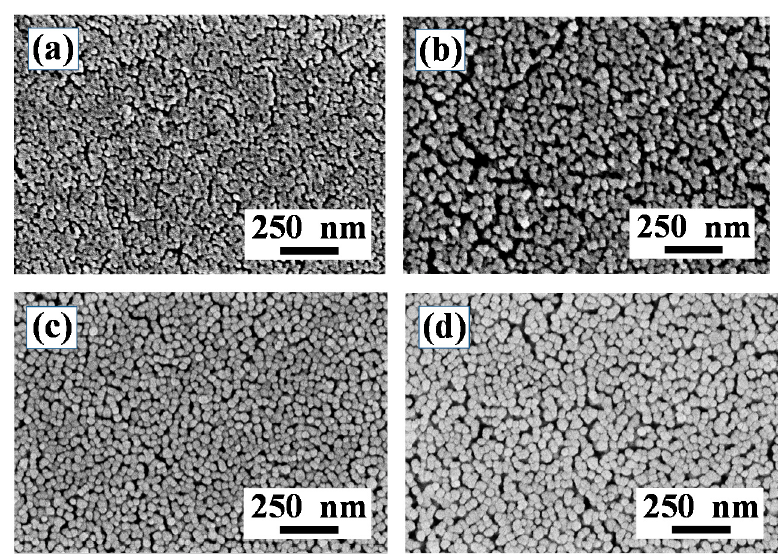
Figure 2. Surface SEM images of the L2NiO thin films as a function of annealing temperatures and times: ( a ) 400 ° C for 1 h, ( b ) 400 ° C for 3 h, ( c ) 500 ° C for 3 h, and ( d ) 600 ° C for 3 h.